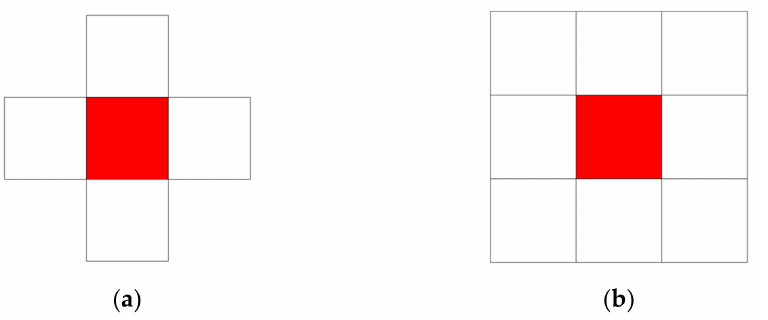
Figure 6. Neighborhood location calculation. ( a ) Four neighborhoods; ( b ) Eight